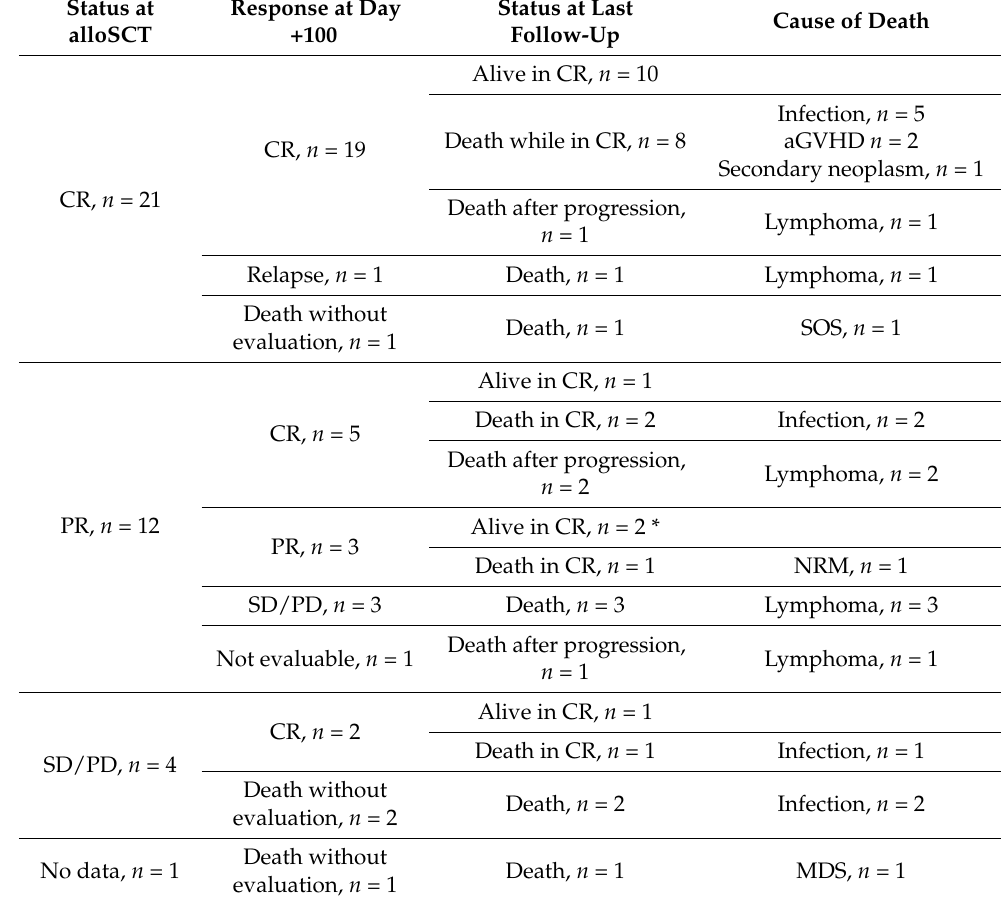
Table 2. Response to transplantation and current status of